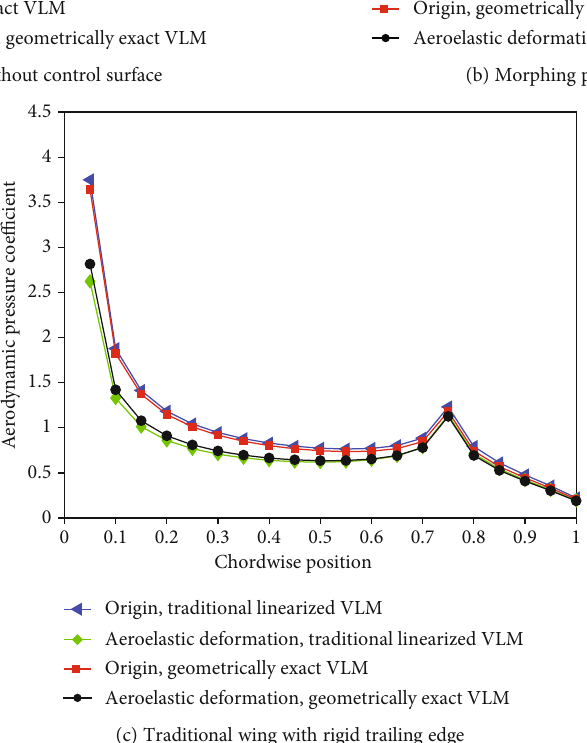
Figure 7: Aerodynamic load redistribution after aeroelastic